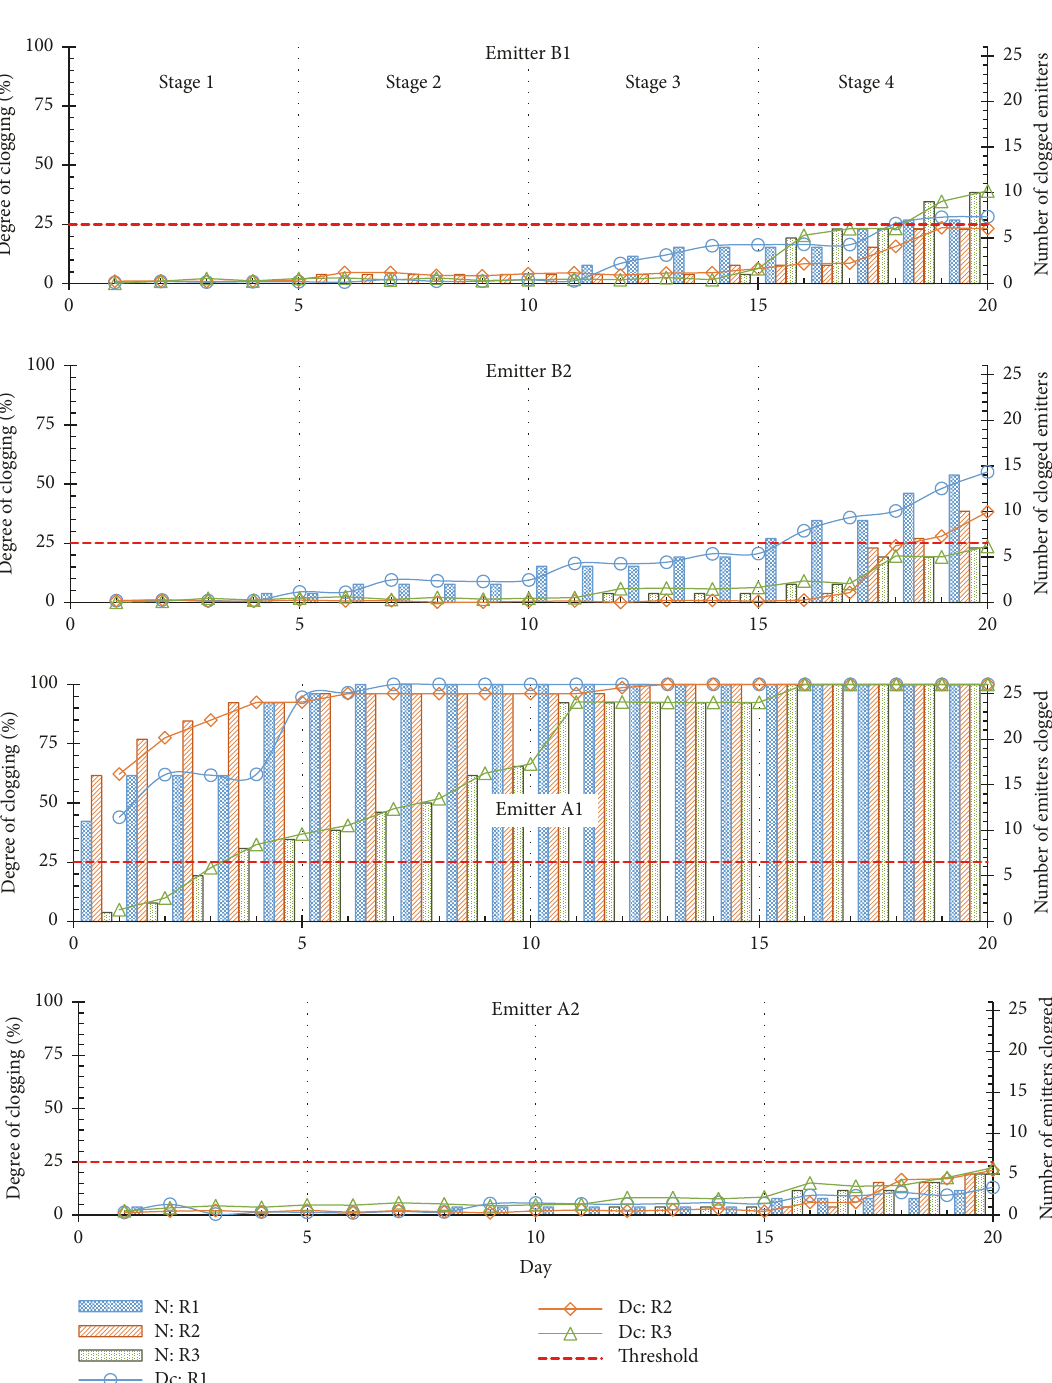
Figure 2: Degree of clogging and number of clogged emitters during the experiments accounting for 3 replications (R1, R2, and R3); N is the number of clogged emitters (i.e., flow rate decreased by more than 25% from the initial value); Dc represents the degree of clogging (1). The threshold represents the level at which clogging is considered to